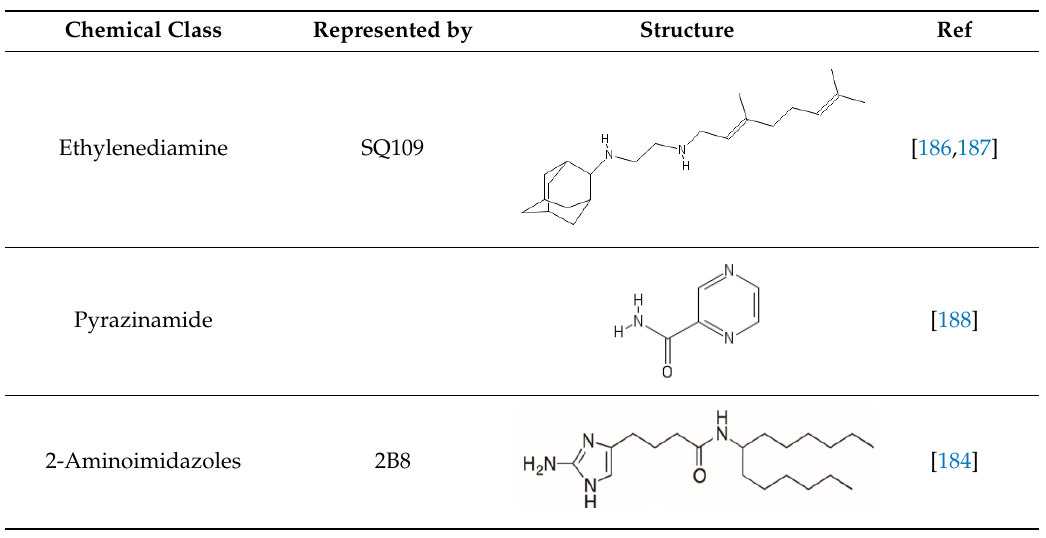
Table 5. Inhibitors of the mycobacterial proton motive force (PMF) discuss in this